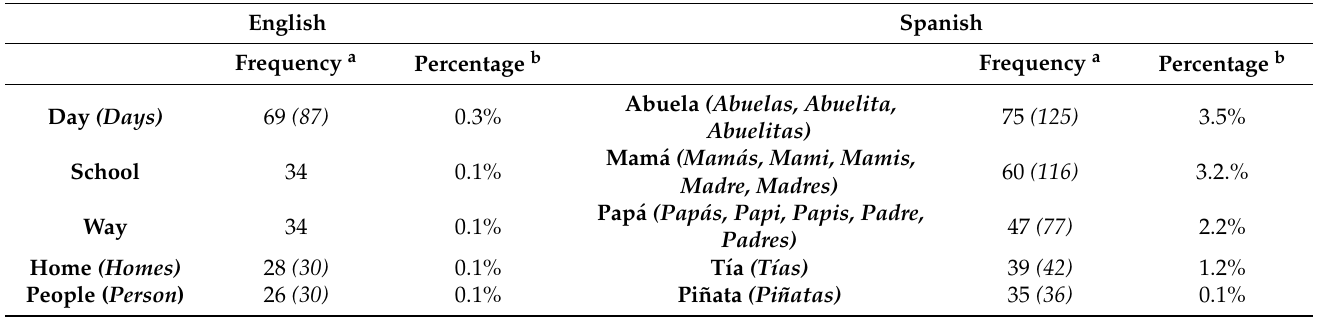
Table 4. 5 most frequent nouns per language, including close variants and